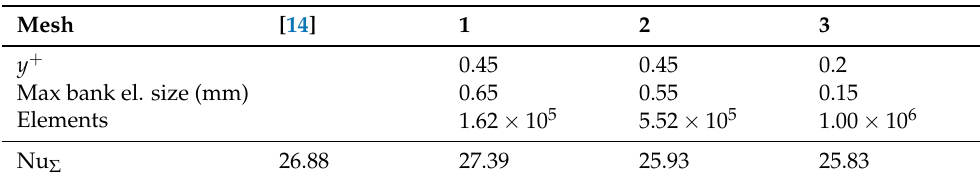
Table 3. Mesh sensitivity results for LBE tube bank cross-flow at Pe m = 1.2 × 10 3 , Pr t = 0.85 and ∆ t = 50 (µs). Please note that y + indicates the distance of the first mesh element from the wall in wall length units.